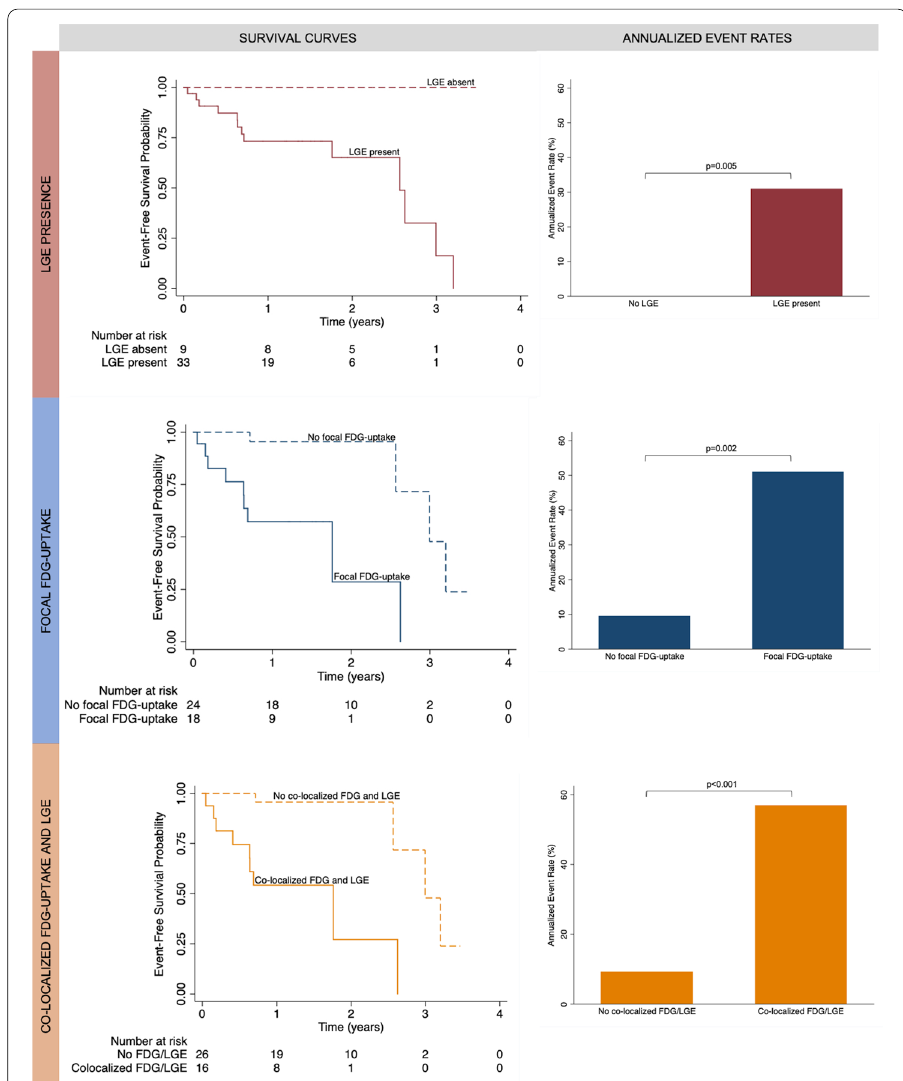
Fig. 4 Kaplan–Meier survival probability curves for the primary end‑point of major adverse cardiac events (MACE) demonstrate that patients with late gadolinium enhancement (LGE), focal FDG uptake, and co‑localized focal FDG uptake and LGE have worse event‑free survival compared to patients without those findings. The number of patients at risk is shown at the bottom of the figures. Annualized event rates were higher in patients with LGE, focal FDG uptake, and co‑localized focal FDG uptake and